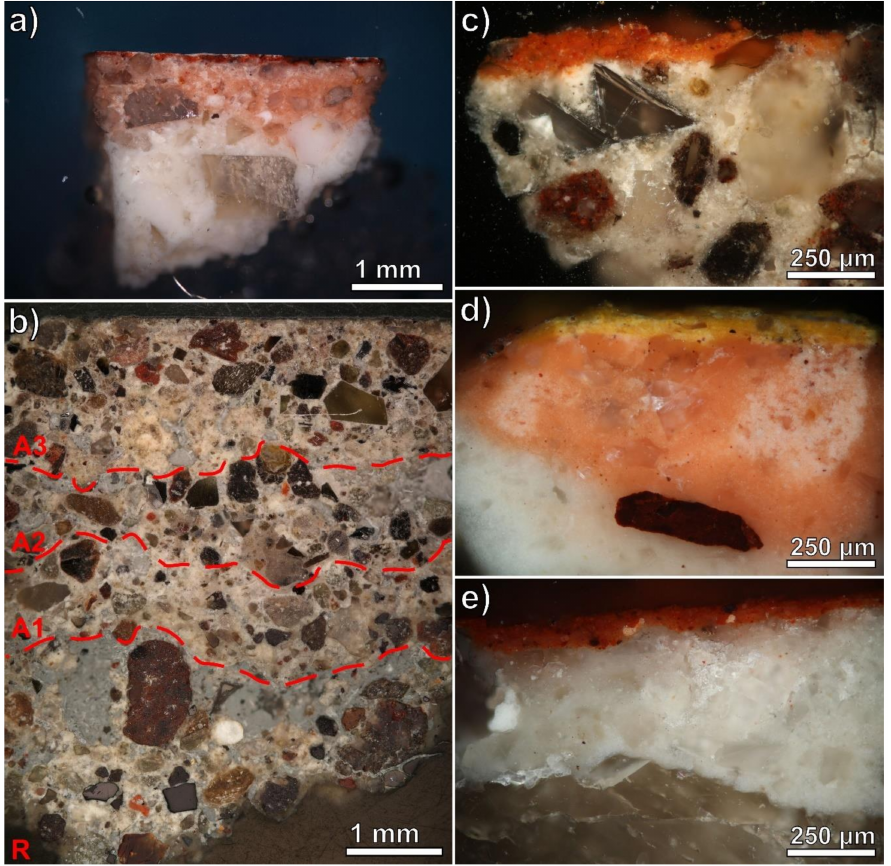
Figure 3. Results of the microstratigraphic analyses on the Herculaneum samples (all the reported micrographs have been taken in reflected light, crossed polars): ( a ) sample BCN_59, lime/marble dust aggregate-based finishing plaster; ( b ) full stratigraphy of the lime/volcanic aggregate-based preparatory plaster sequence (R: uppermost portion of base rough (rinzaffo) plaster; A1, A2, A3: progressively finer (arriccio) plasters placed before the finishing plaster); ( c ) east base register, paint layer applied directly over the uppermost preparatory plaster; ( d ) sample BCN_28, the pink- tinted plaster, a macroscopic pigment lump at the base of the pink-tinted plaster and the paint layer are visible; ( e ) sample BCN_31, the uppermost portion of the finishing plaster and the paint layer are